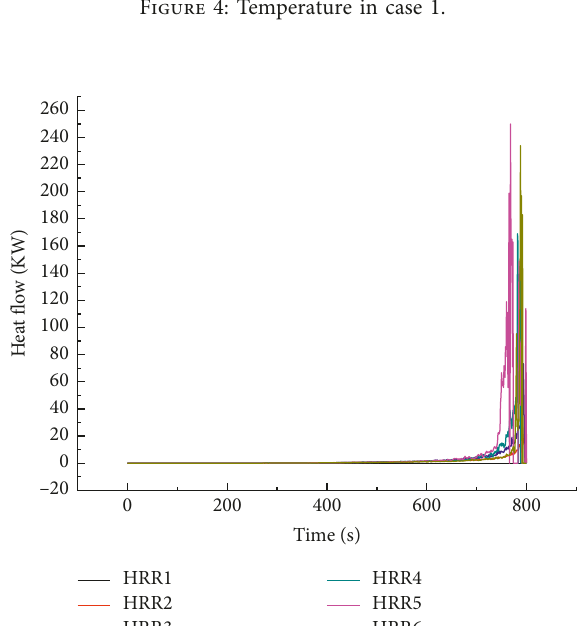
Figure 4: Temperature in case